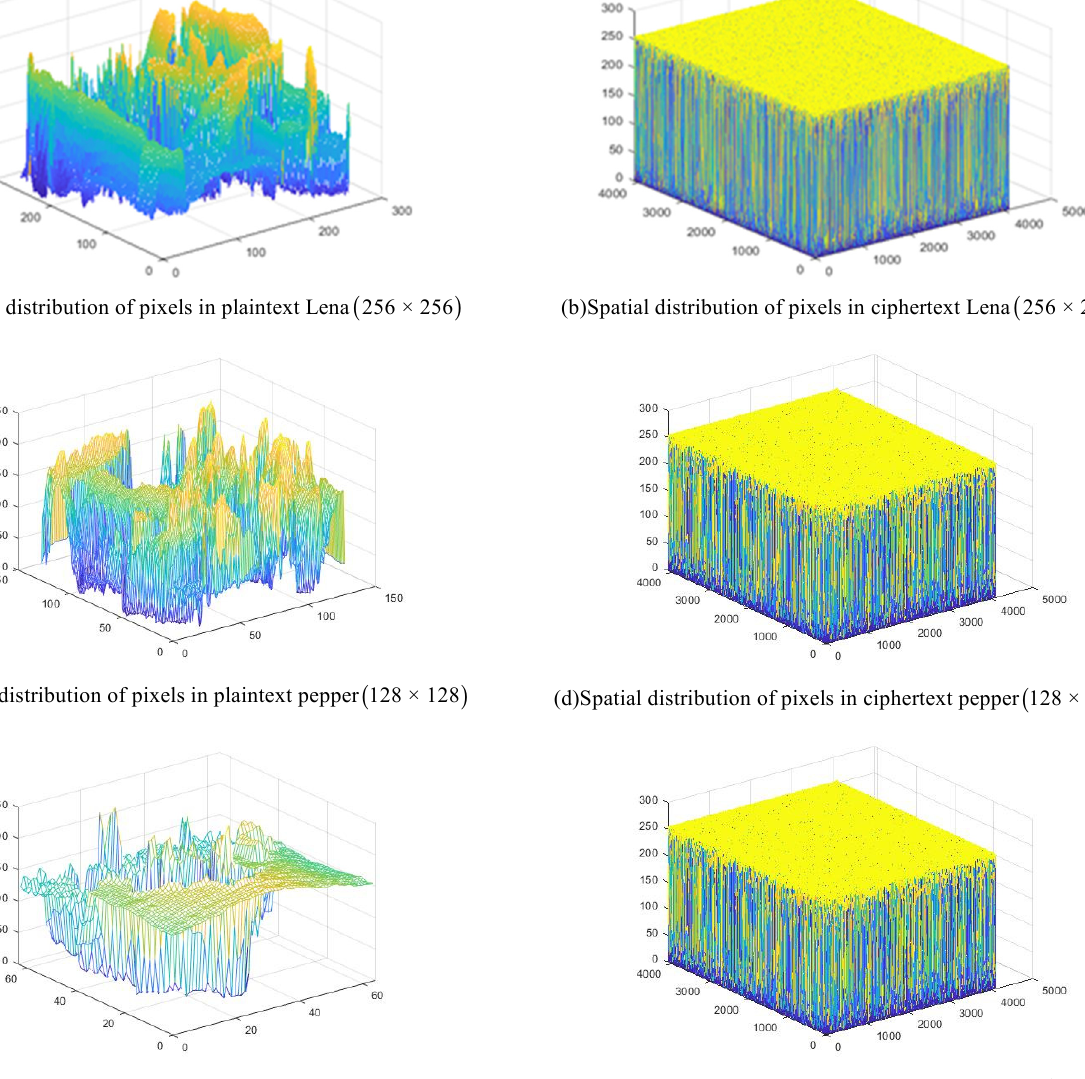
Figure 12. Spatiotemporal histogram of the plaintext image and the ciphertext image.